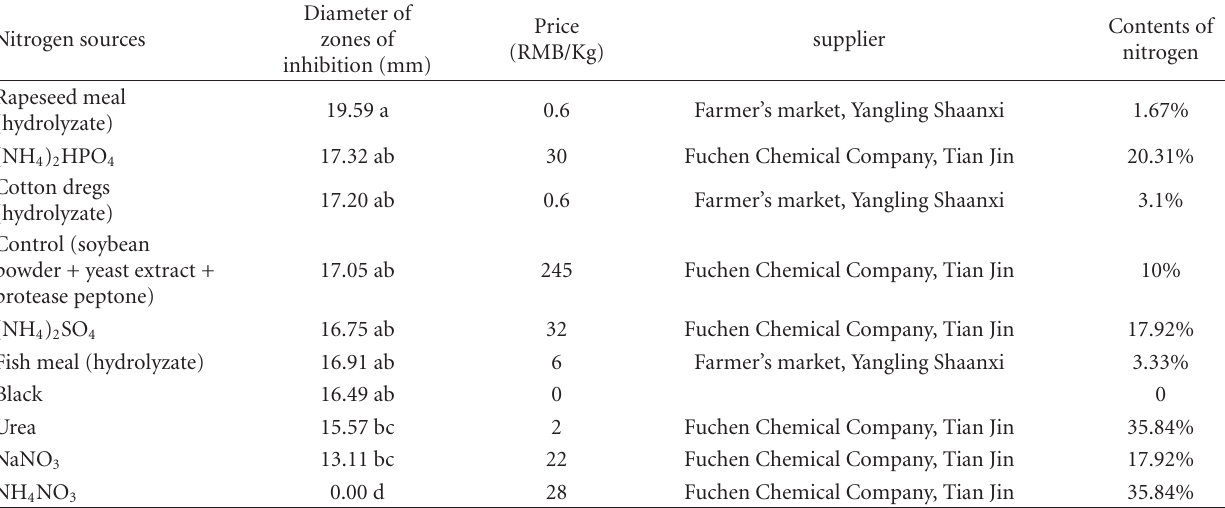
Table 2: E ff ect of various nitrogen sources replacing soybean powder, yeast extract, and protease peptone in SSY medium on